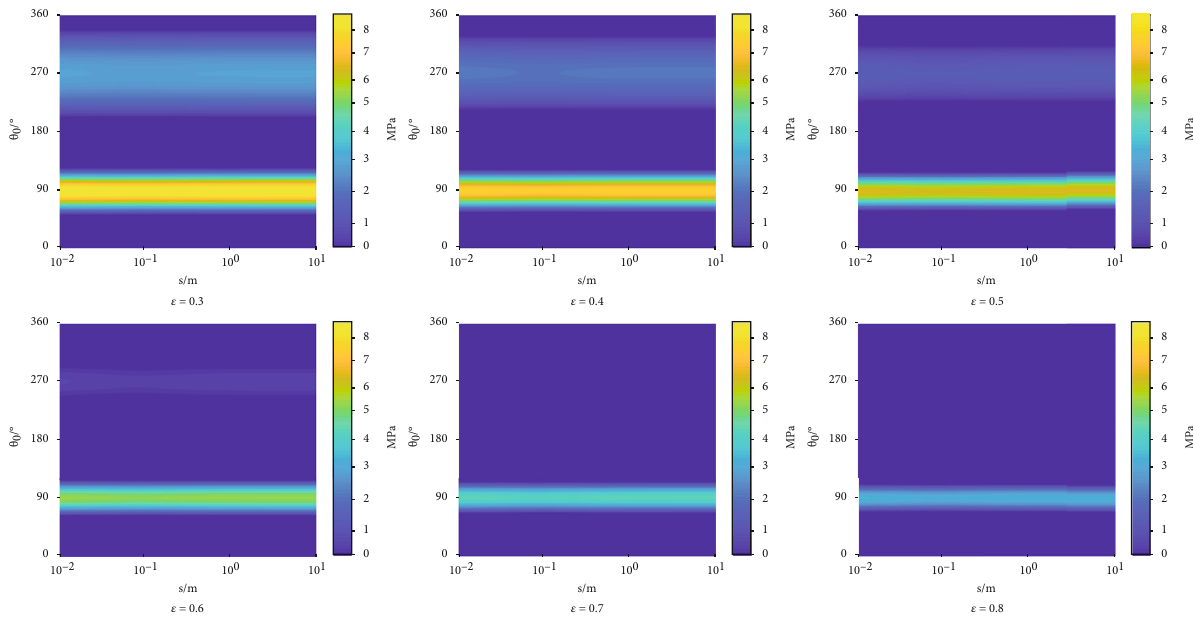
Figure 16: Maximum tensile stress increasing region with di ff erent Biot coe ffi